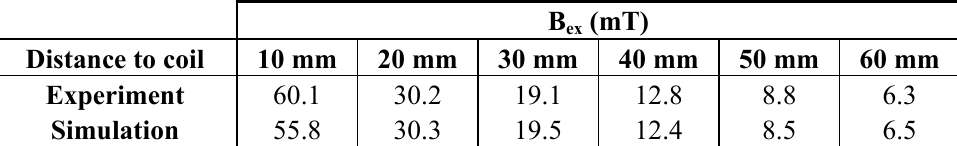
Table 6. Results of the validation of the numerical model of the cylindrical coil using an effective current of 2.24